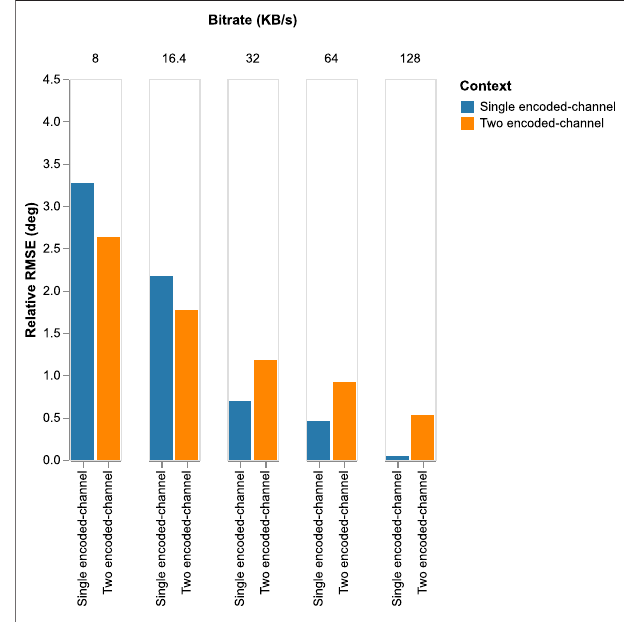
FIGURE 14 | Relative RMSE degradation for a varying bitrate performed for the two models: 1) Single encoded-channel model where one of the channelsiswithoutcompressionandthesecondisencodedwithEVSandthe internal delay has been compensated. 2) The two encoded-channel modelwherethetwoinputsareencodedsimilarlywithEVSatavaryingbitrate.